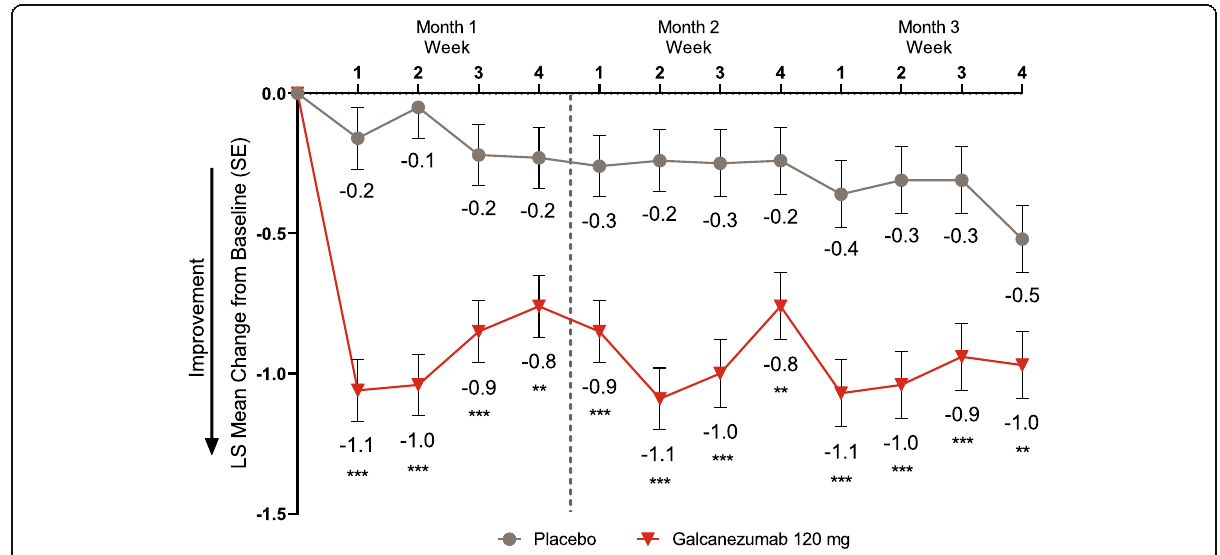
Fig. 2 LS mean change from baseline in number of weekly migraine headache days. ** p < 0.01, *** p ≤ 0.0001 vs placebo. LS least-squares. SE standard error. Dotted line separates month 1, which was used in the onset analysis, from remaining